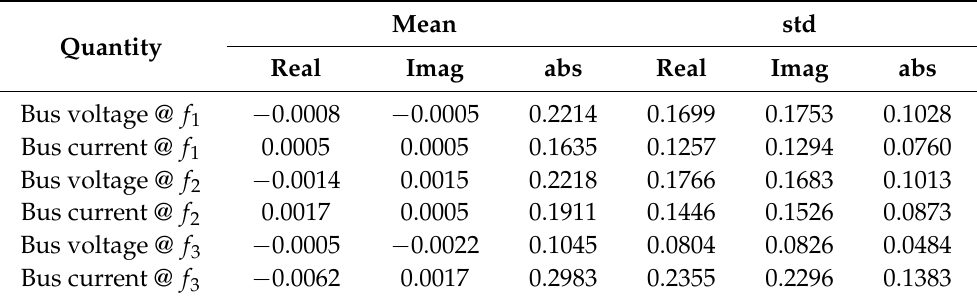
Figure 13. ( a , b ) Results of MCM simulations for the three-converter network with converters sepa- rated by 5m of line cable segments (proximal converters configuration). Table 2. Measures of dispersion of the MCM simulations for the three-converter network with 100m of line cable separation between converters.